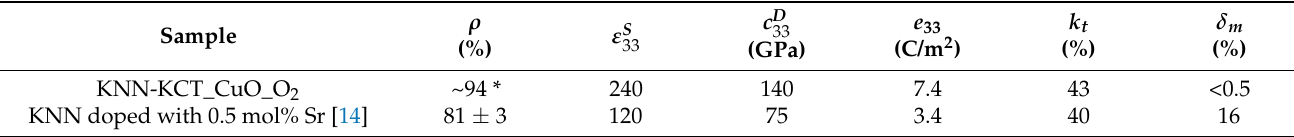
ρ : relative density (*: value obtained from the image analysis of porosity), ε S stant at constant electrical displacement, e 33 piezoelectric coefficient, k t : effective thickness coupling coefficient, δ m : mechanical losses. All measurements were performed at room